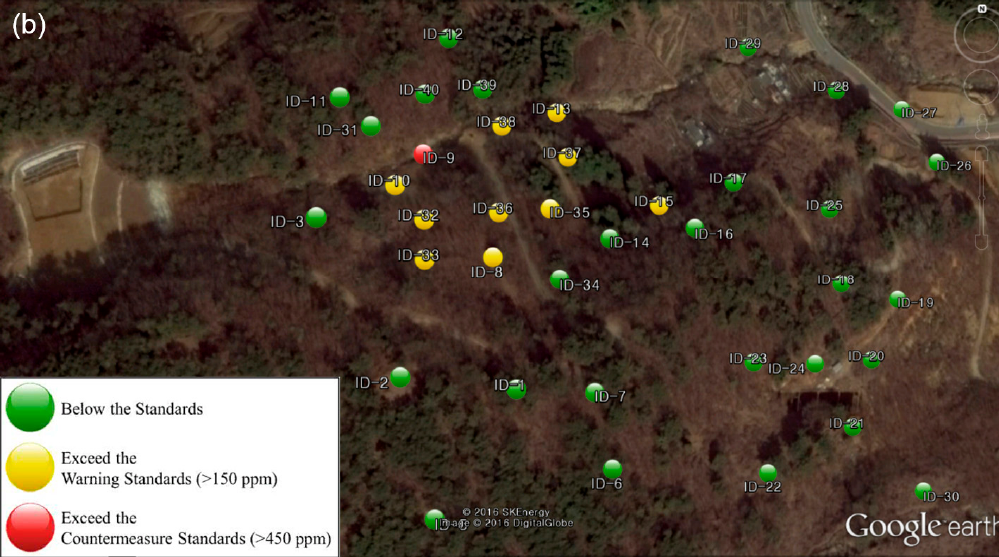
Figure 6. Results of PXRF elemental analysis. ( a ) Distribution of Cu concentration; ( b ) Google Earth screenshot of distribution of Cu content according to the environmental risk countermeasure criteria.